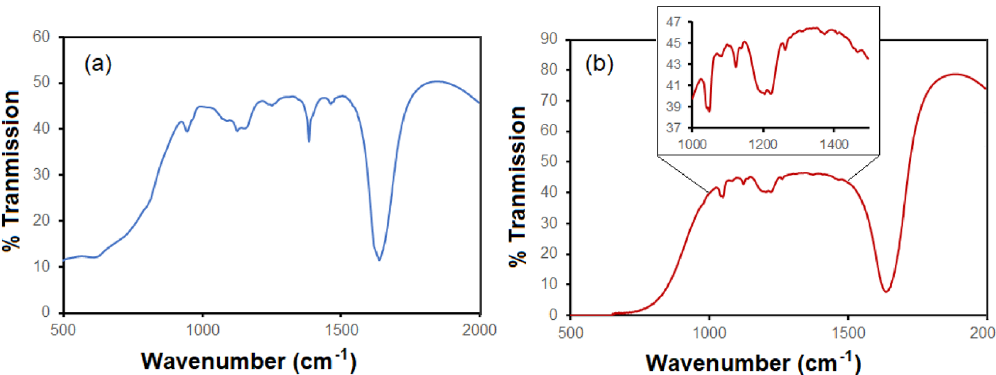
Figure 4. ( a ): FTIR spectrum (Transmission mode) of synthesized MoS 2 nanosheets; ( b ): FTIR (Attenuated Total Reflection mode) spectrum of antibody conjugated L-Cysteine/MoS 2 nanosheets deposited on a silicon substrate.